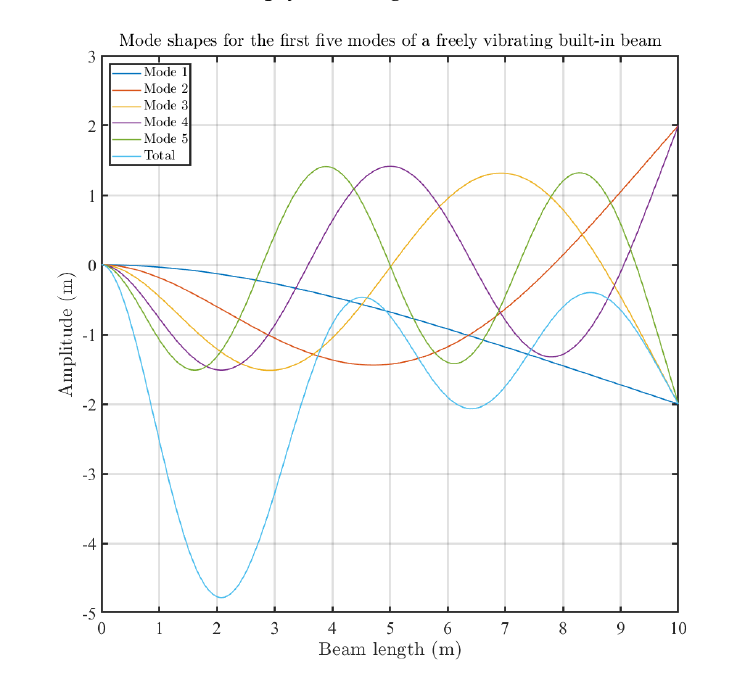
Figure A1. First five mode shapes for a freely vibrating cantilevered